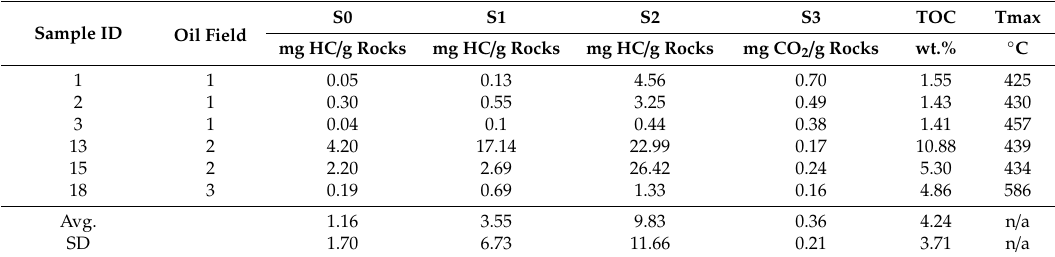
Table 6. Pyrolytic properties of samples after